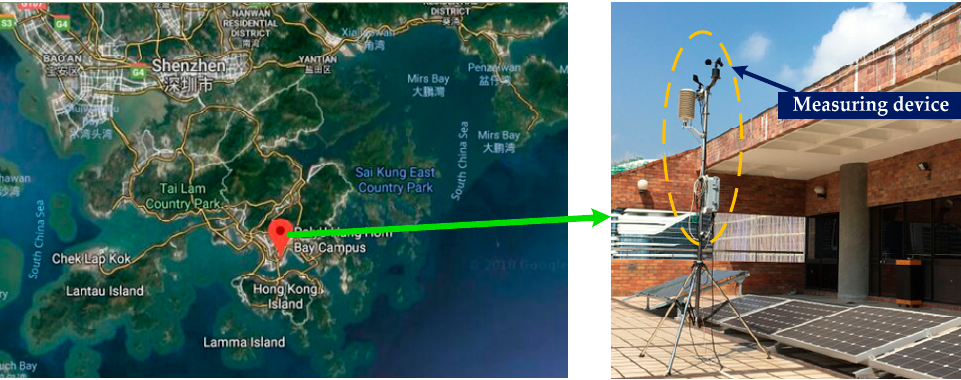
Figure 11. Figure 11. The detailed geographical position of the measuring device for solar irradiation and temperature.